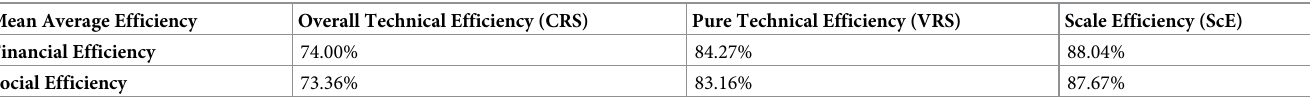
Table 5. Comparison of efficiency scores of the partner